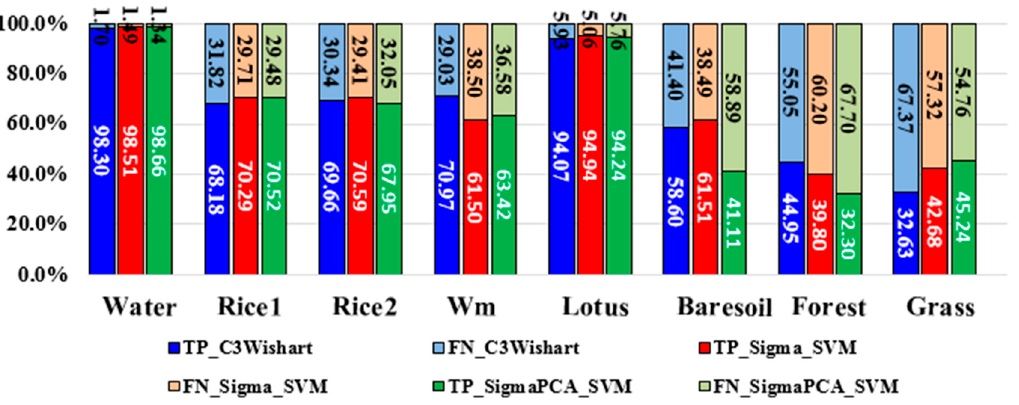
Figure 13. The true positive (TP) rates and the false negative (FN) rates of different polarimetric classification methods. Wm means watermelon.